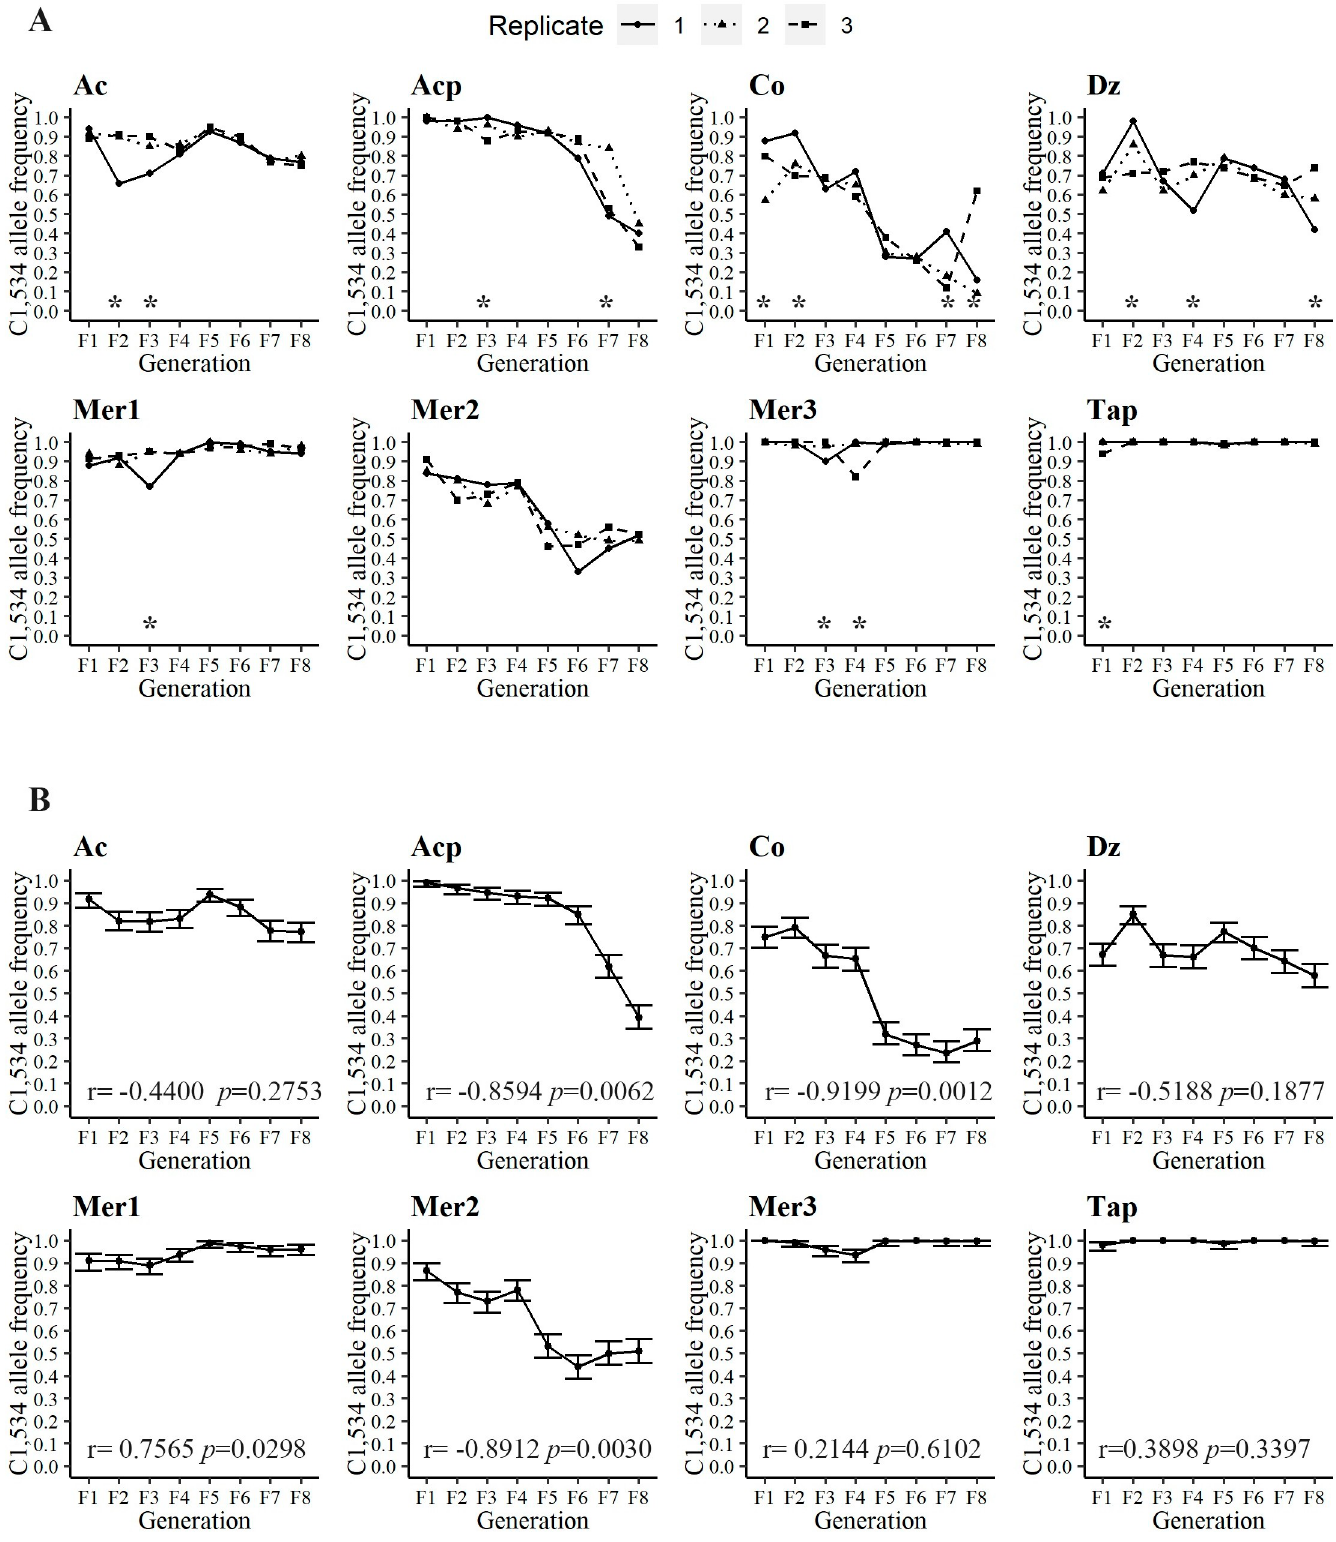
Fig 4. Frequency of genotypes at locus V1,016I over eight generations in the absence of pyrethroids. A) Susceptible-homozygote = VV 1,016 , B) Heterozygote = VI 1,016 , and C) Resistant-homozygote = II 1,016